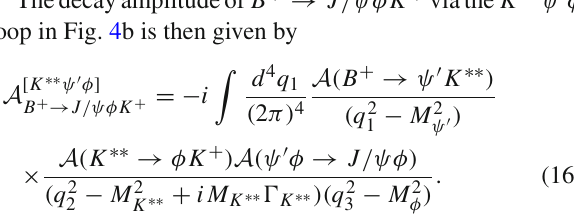
Fig. 6 Invariant mass distribution of J /ψφ via the rescattering pro- cesses in Fig. 4. For a : The mass and width of K ∗∗ with J P = 1 + are taken to be those of K 1 ( 1400 ) (solid line), K ( 1860 ) (dotted line), and